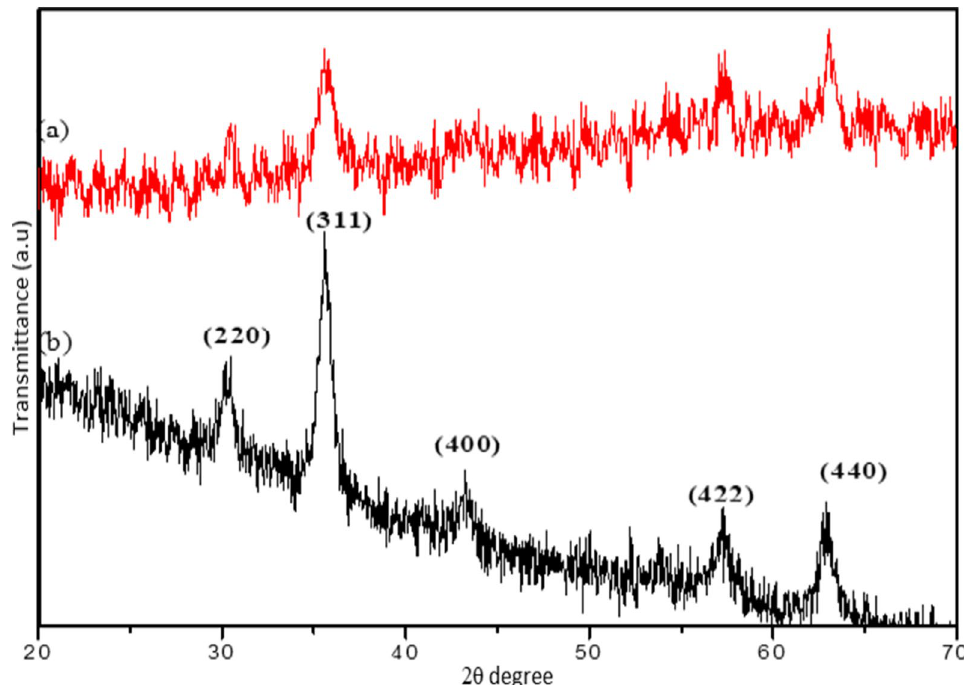
Fig. 4 XRD patterns of (a) Fe 3 O 4 @ MAA-βCD and (b) bare Fe 3 O